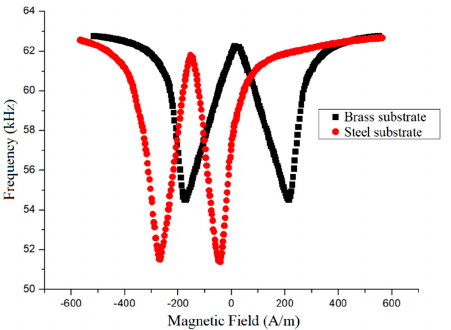
Figure 5. Compound ∆ E curve for brass substrate (black) and thermally demagnetized steel (red)